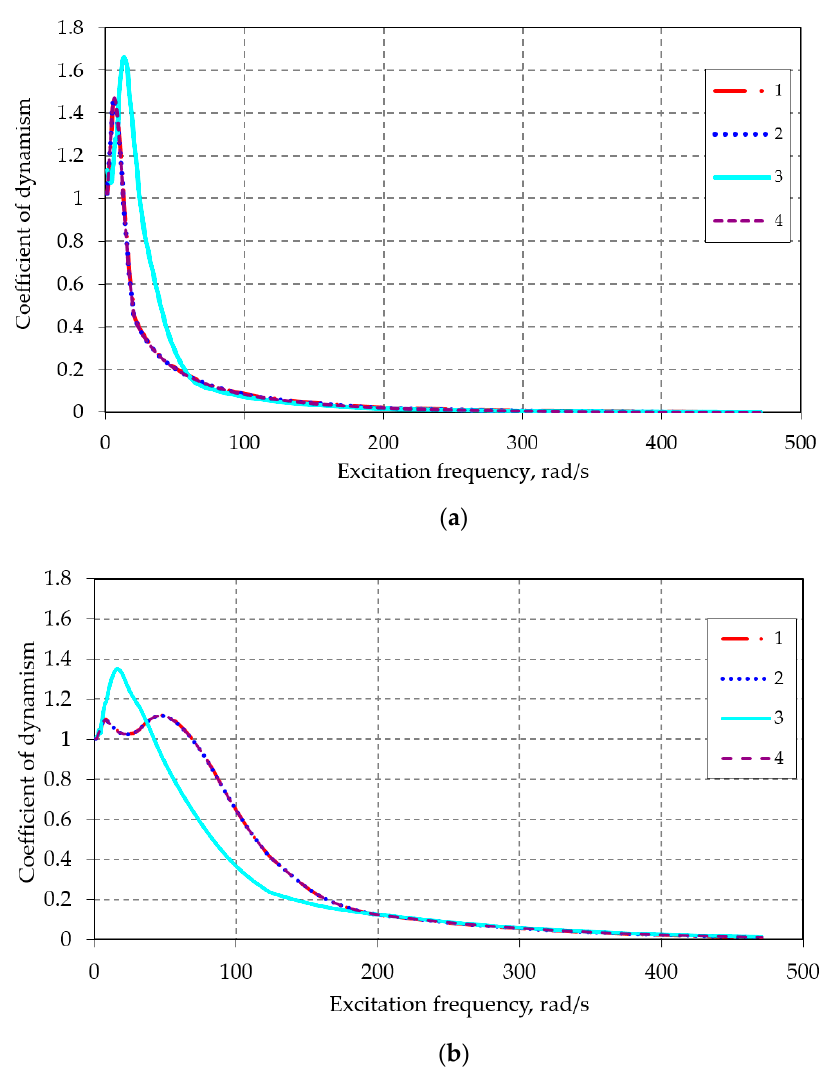
Figure 20. Influence of nonlinear damping of shock absorbers and nonlinear stiffness of suspension on the sprung ( a ) and unsprung ( b ) mass displacements: 1—linear shock absorber and linear suspension, tread not assessed; 2—tread assessed; 3—nonlinear shock absorber; and 4—nonlinear suspension.